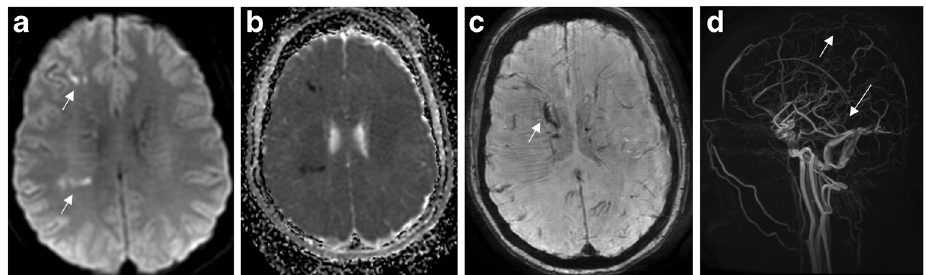
susceptibility along callososeptal veins, right greater than left ( arrow ). Magnetic resonance venography (MRV) ( d ) demonstrates loss of flow- related enhancement in the superior sagittal sinus and expected location of the internal cerebral veins, vein of Galen, and straight sinus ( arrows )